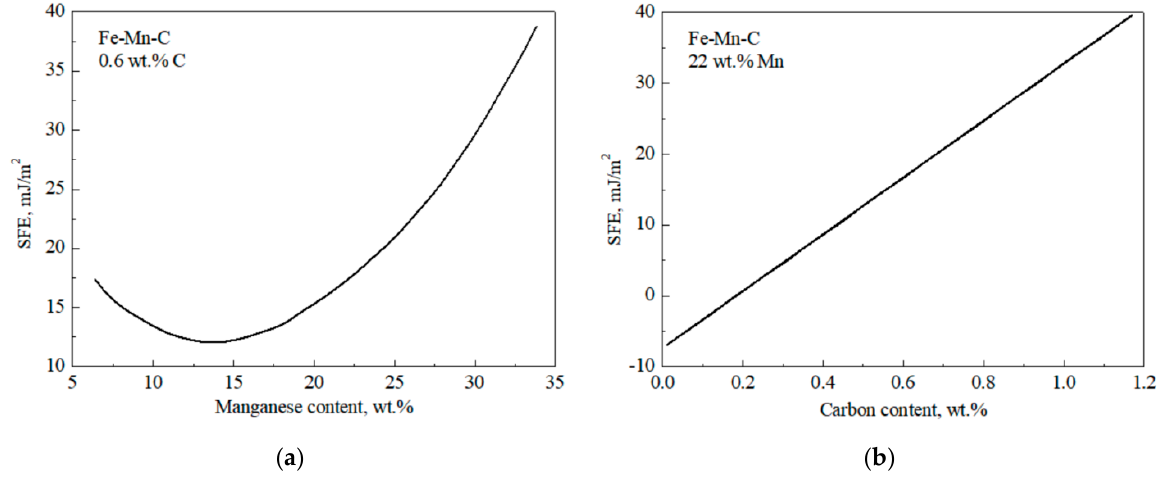
Figure 2. ( a ) Isocarbon (0.6 wt.%) and ( b ) isomanganese (22 wt.%) stacking fault energy diagrams with different temperatures (Reprinted with permission from Ref. [28], Copyright 2022 Springer Nature).